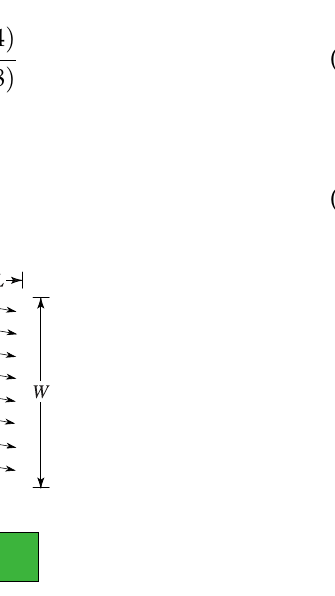
Figure 1. Fundamental mode half-wave microstrip resonator model of patch